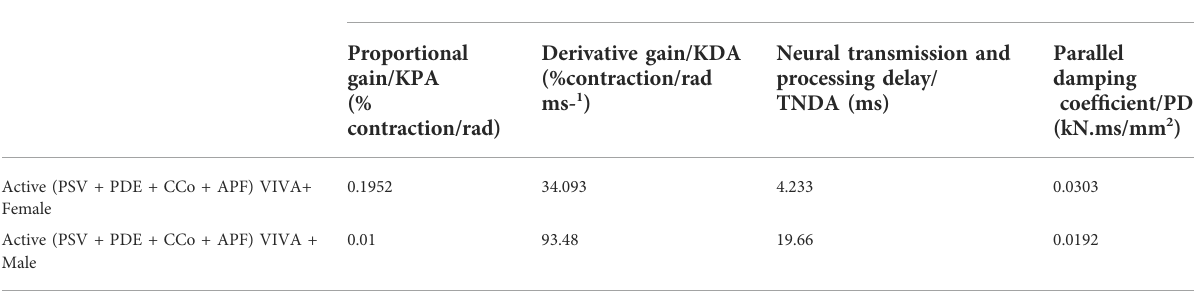
TABLE 3 Active (PSV + PDE + CCo + APF) muscle controller parameter based on optimization.